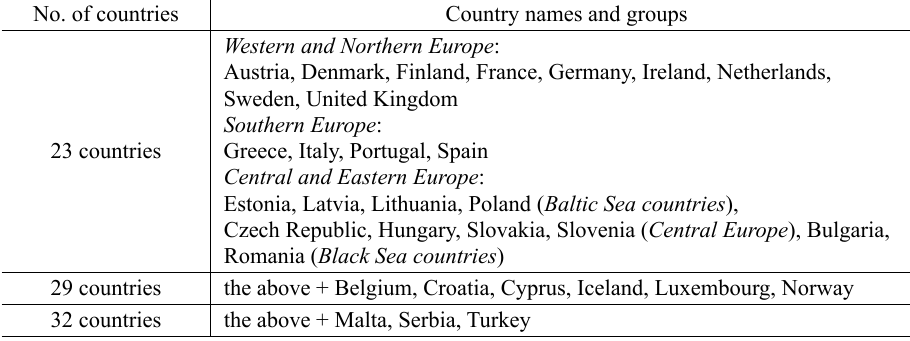
Table A2. Base and final period years for indicators of innovation capabilities Indicator No.